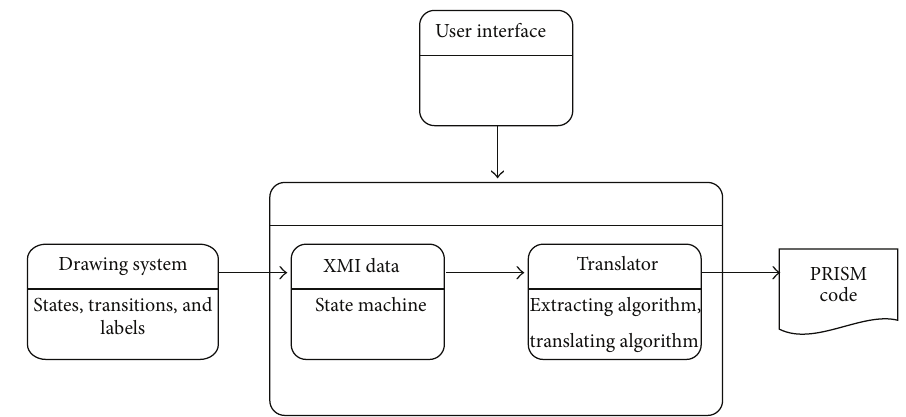
Figure 5: Functional components of DP [19].